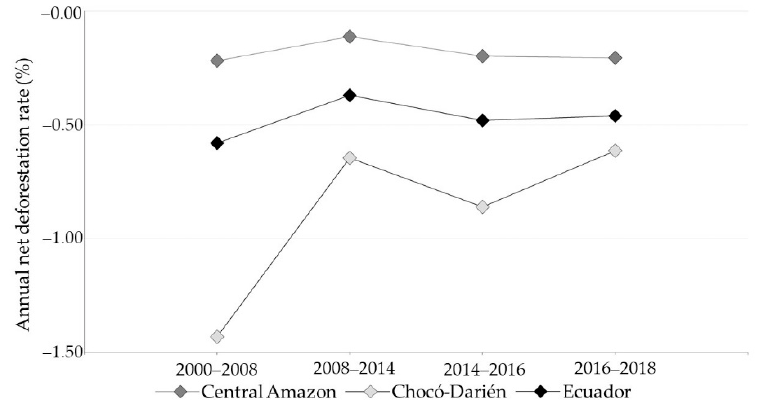
Figure 1. Annual net deforestation rate in the study areas selected. The periods 2000–2008, 2008–2014, 2014–2016, and 2016–2018 correspond to the national deforestation assessments carried out by the Ministry of Environment of Ecuador. Source: authors’ own elaboration based on the information available in the Ecuadorian system for environmental information (SUIA by its Spanish acronym ) [7] .